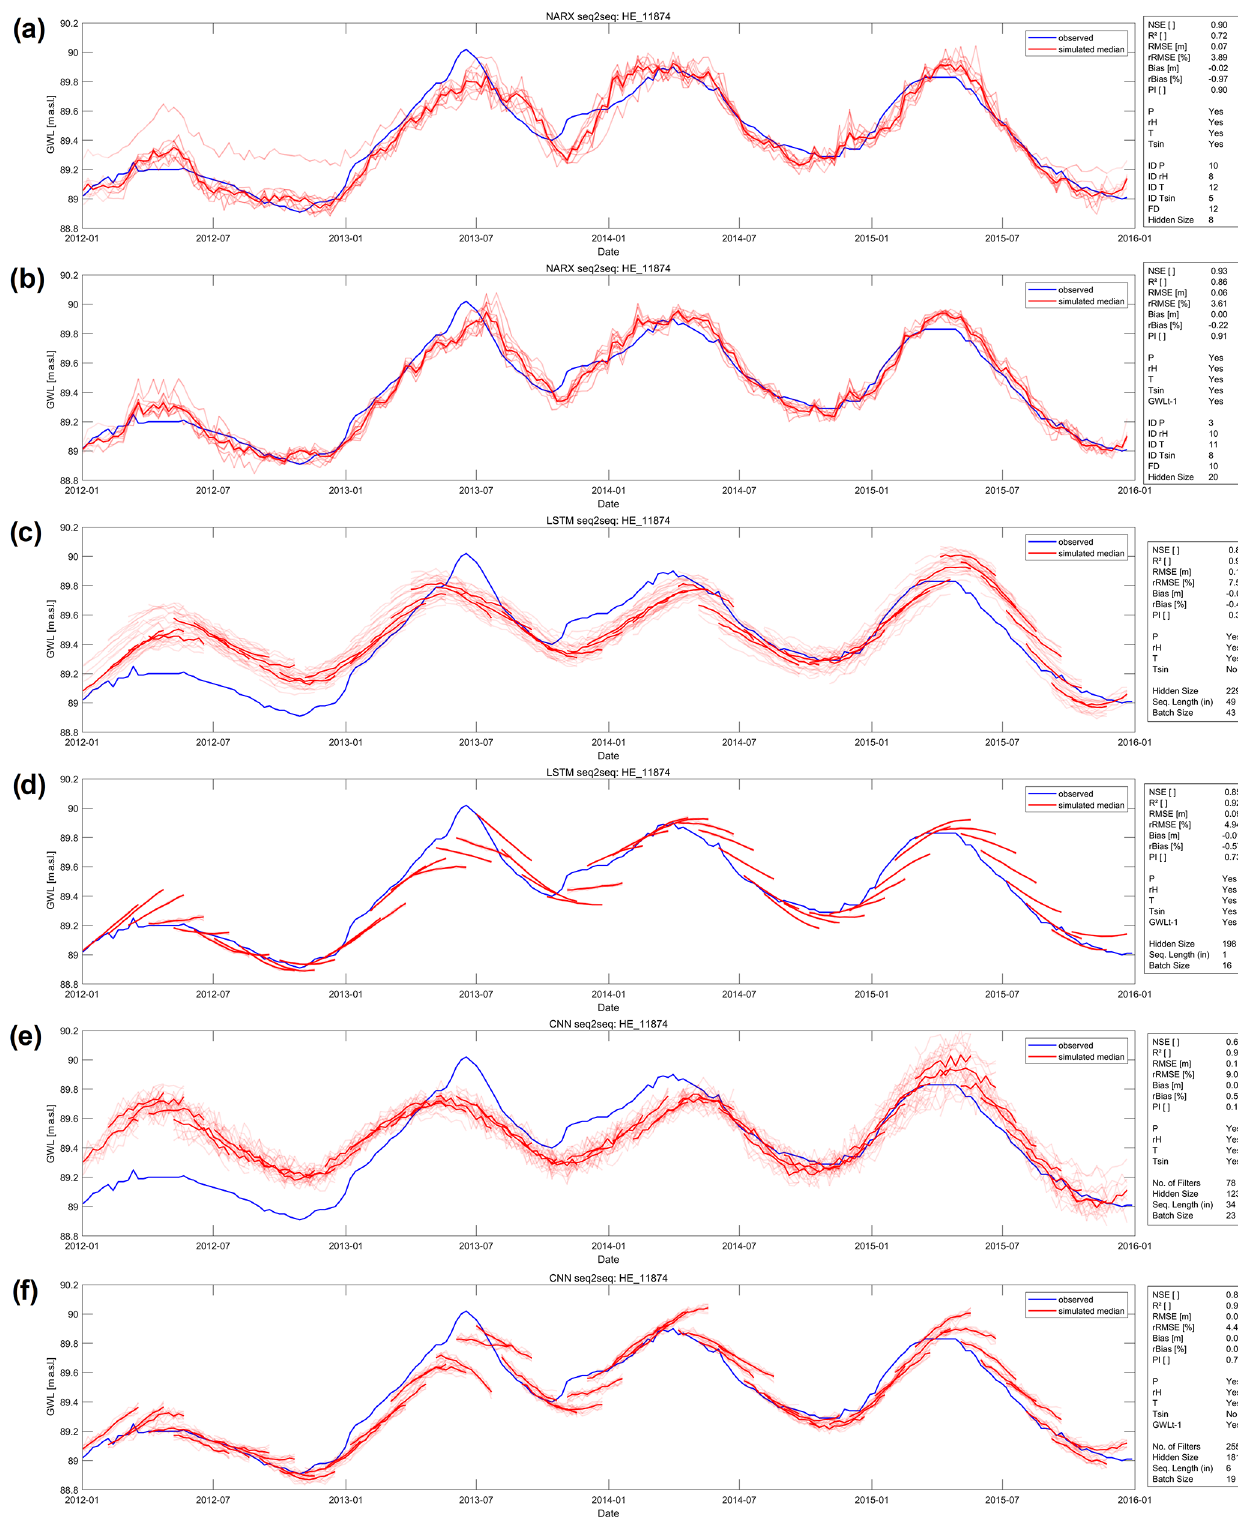
Figure 8. Forecasts of (a, b) a NARX, (c, d) a LSTM, and (e, f) a CNN model for well BW_104-114-5 during the test period 2012–2016. Models in (a, c, e) use only meteorological input variables, and models in (b, d, f) use also past GWL observations.